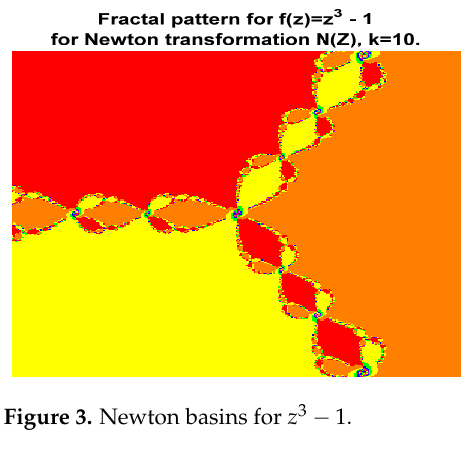
Figure 2. Detailed of a bulb from Figure 1.